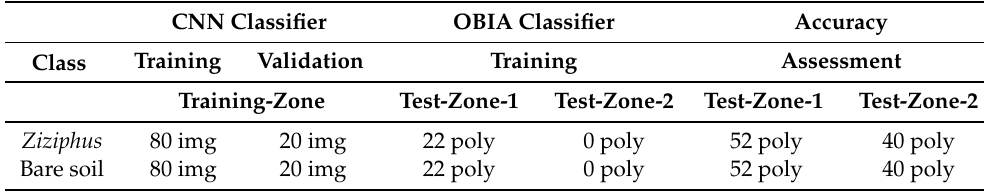
Table 1. Training and testing datasets for both CNN and OBIA used for mapping Ziziphus lotus shrubs. Bare soil: Bare soil and sparse vegetation; Img: 80 × 80-pixel image patches; Poly: digitized